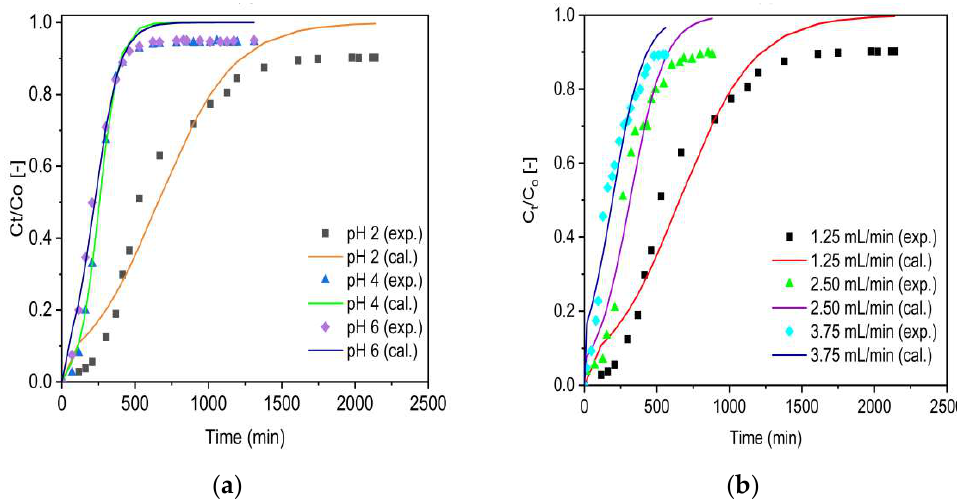
Figure 9. Experimental (exp.) and simulated (cal.; Adams–Bohart model) breakthrough curves of fluoride for ZrOCSc at different ( a ) pH (C O : 10 mg/L; Q O : 1.25 mL/min; bed depth 10 cm) and ( b ) Q O (pH 2; C O : 10 mg/L; bed depth 10 cm).